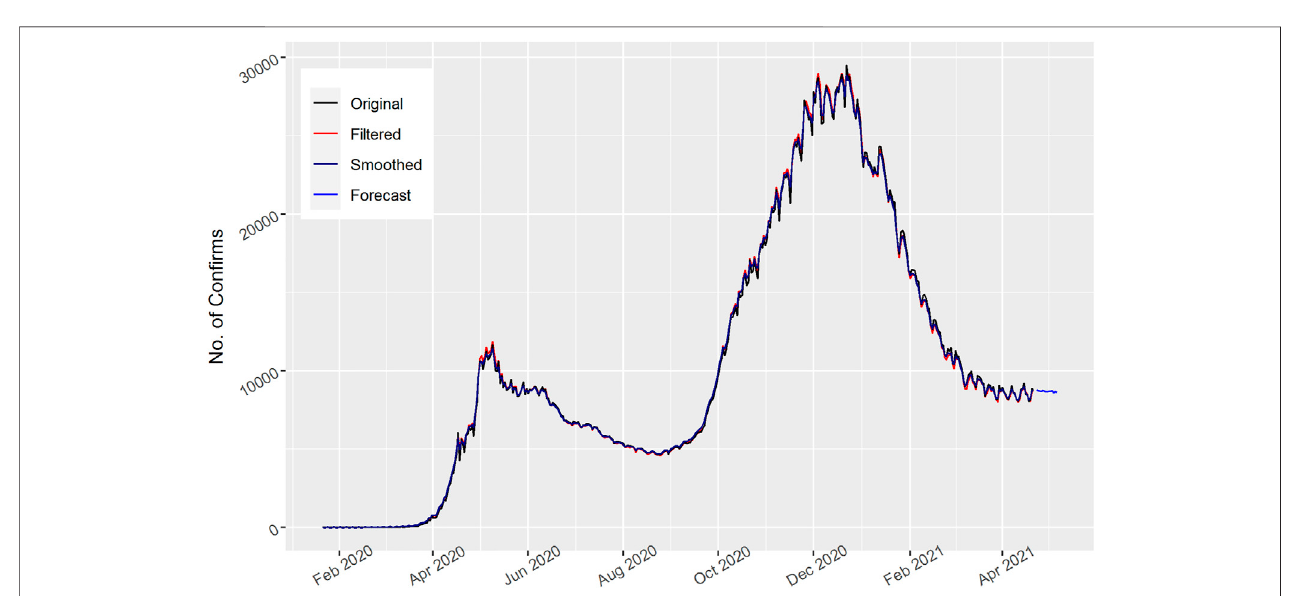
FIGURE 4 | Number of daily Con fi rmed cases in